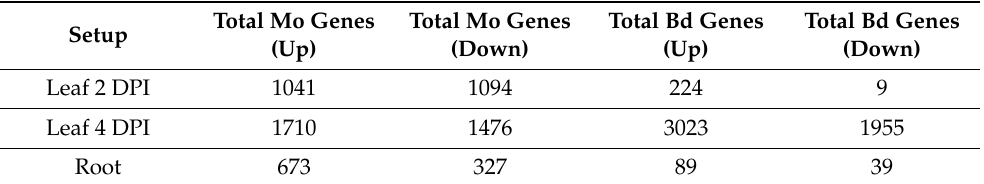
Table 1. Total numbers of significantly (padj < 0.05) upregulated or downregulated genes in the B. distachyon – M. oryzae interaction.